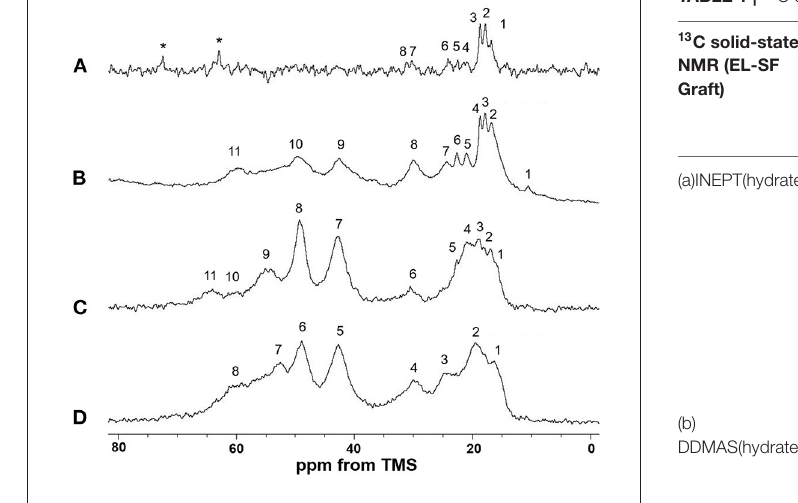
FIGURE 6 | Expanded (0–80 ppm) regions of (A) 13 C INEPT, (B) 13 C DD/MAS and (C) 13 C CP/MAS NMR spectra of elastin (EL)–silk fibroin (SF) grafts in the hydrated state with (D) 13 C CP/MAS NMR spectrum of EL–SF graft in the dry state. The assignment of the peaks numbered in the spectra is summarized in Table 1 . Two peaks marked by *in (A) are due to unidentified impurities. The Ala C β peak with anti-parallel β -sheet structure from SF is considered to be the main peak at around 20 ppm in the range from 15 to 25 ppm in (C) .